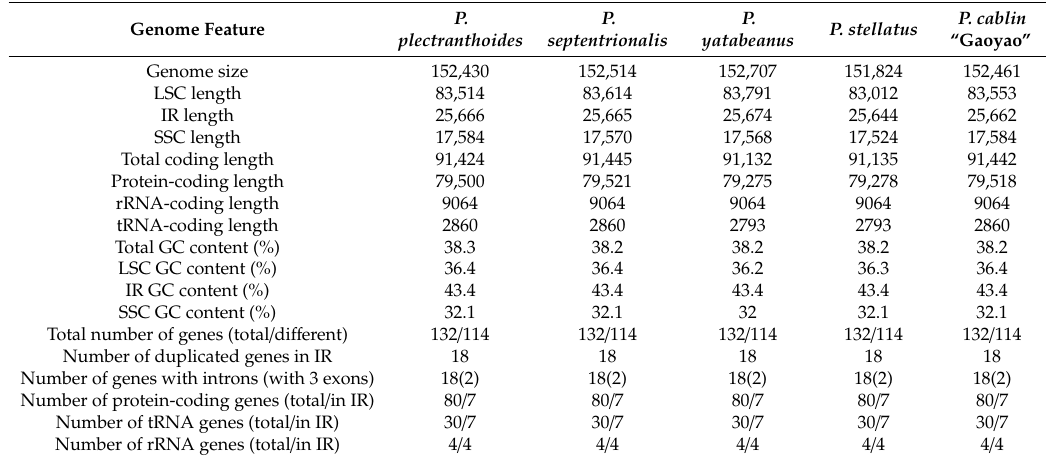
Table 1. Characteristics of chloroplast genomes from five species in the genus Pogostemon . Genome Feature